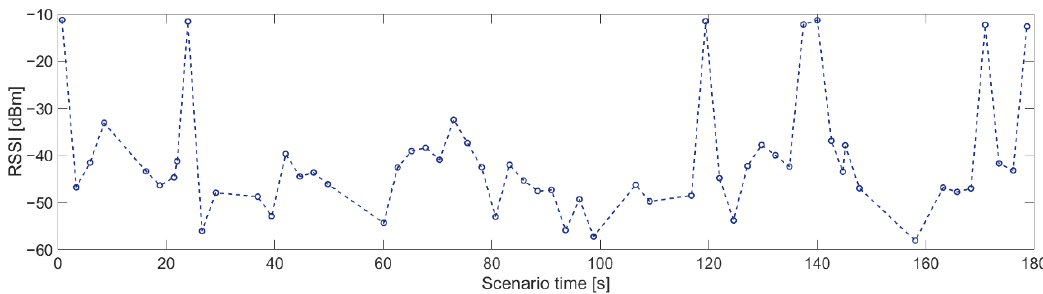
Sensors 2021 , 21 , x FOR PEER REVIEW Figure 18. Distribution of transmission time breaks for relationship 4 and 3. Figure 18. Distribution of transmission time breaks for relationship 4 and 3.